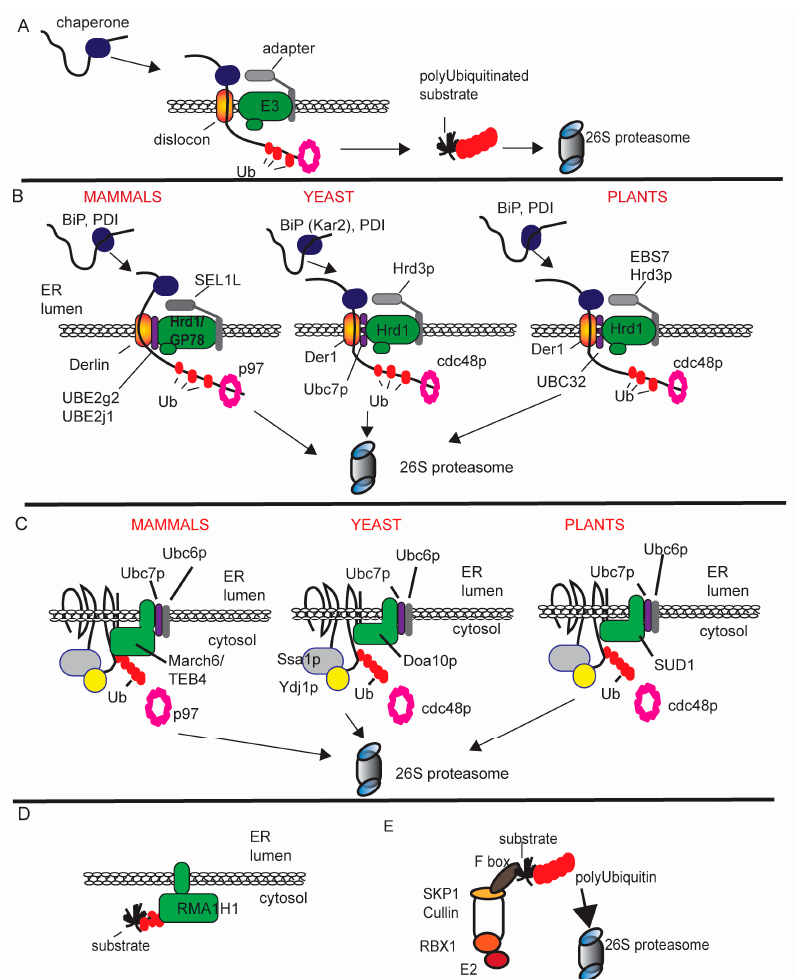
Figure 1. Diagrammatic representation of the classes of ubiquitin proteasome system (UPS) associated with endoplasmic reticulum (ER) associated degradation (ERAD); ( A ) shows the general features of a functional ERAD machinery and retrotranslocon found in eukaryotes; ( B ) comparison of the lumenal ERAD machinery in mammals, yeast, and plants; ( C ) comparison of the cytosolic ERAD machinery in mammals, yeast, and plants; ( D ) RMA1 class of E3 Ub ‐ ligases that associate with the ER and modify cytosolic substrates; and ( E ) the SKP1, Cullin, F ‐ box containing complex (SCF complex) is a cytosolic complex that is sometimes linked to ERAD. BiP: lumenal binding protein, PDI: protein disulfide isomerase; Ub: ubiquitin;